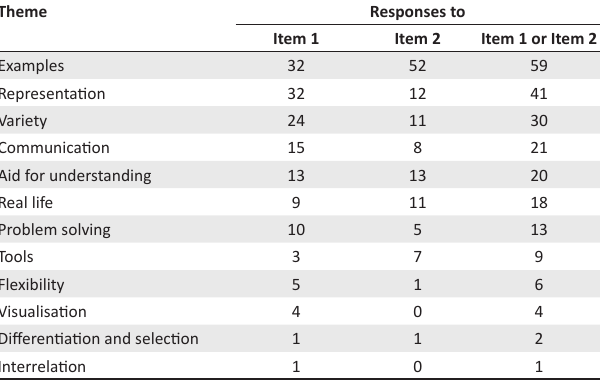
TABLE 2 : The presence of themes in teachers’ responses ( N =